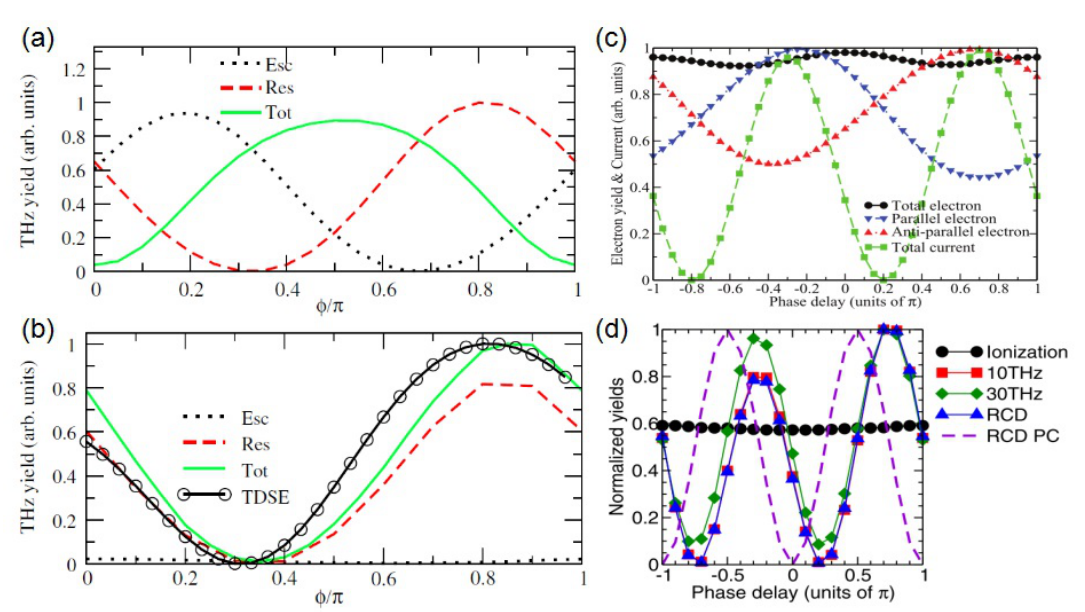
Figure 3. ( a ) THz yields by the escaping (black dotted line), the rescattering (red dashed line), and the total currents (green line) calculated from the plasma current model. ( b ) Calculated classical and 1D-TDSE results of THz yield modulation with the Coulomb interaction. ( c ) Current simulated by the 3D-CTMC method (green squares). ( d ) THz yield modulations below 10 THz (red squares), 30 THz (green diamonds) and the total residual current (blue triangles) calculated by the 3D-TDSE